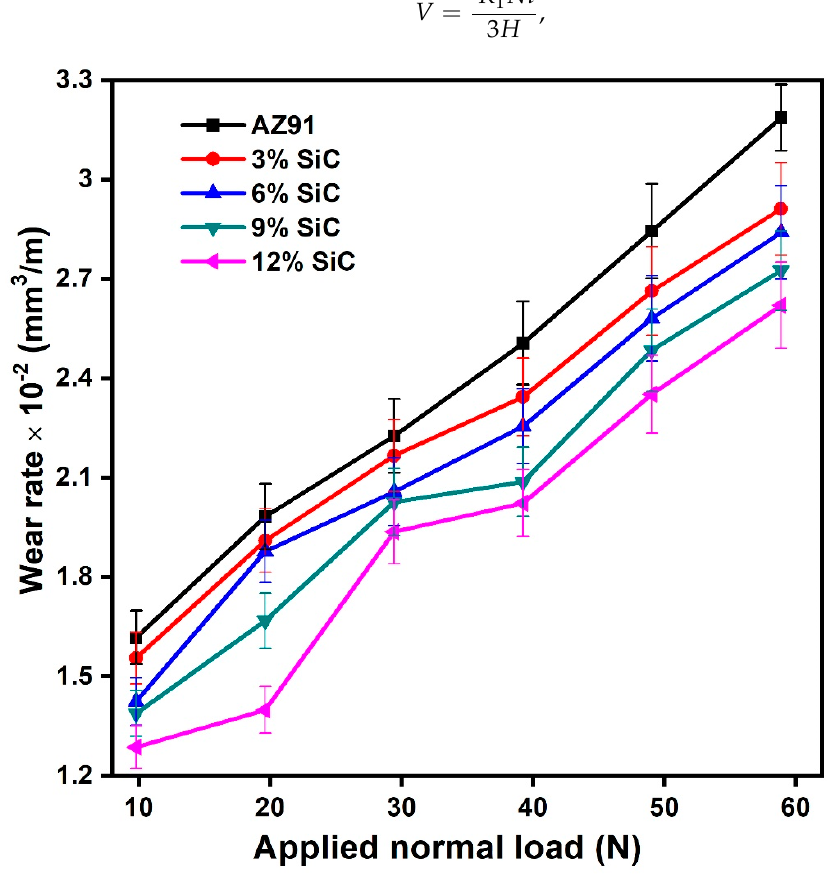
Figure 3. The wear rate variation with an applied normal load of AZ91 magnesium alloy and its composites.